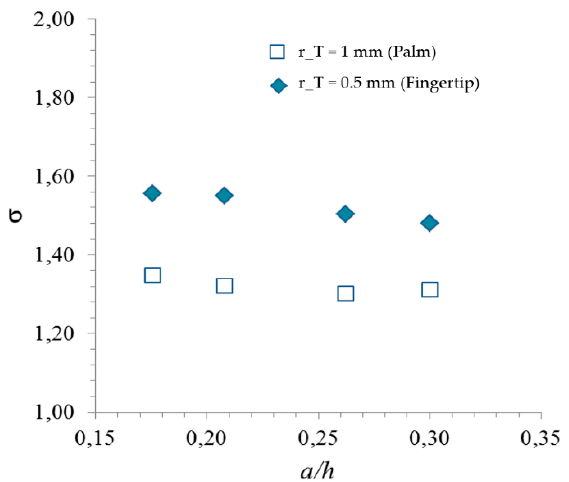
Figure 7. Results for the numerical COMSOL simulations for the finite case. The proportionality coefficient σ between average normal stress T 3 on the sensor and overall (Hertzian) contact force F 3 (2) is plotted versus the imprint radius a (contact size) scaled by the elastomer thickness h. Note that the applied force is centered on the sensor. The two curves are associated to two different sensor sizes: r T = 1 mm (sensors on the palm), r T = 0.5 mm (sensors on the fingertip).